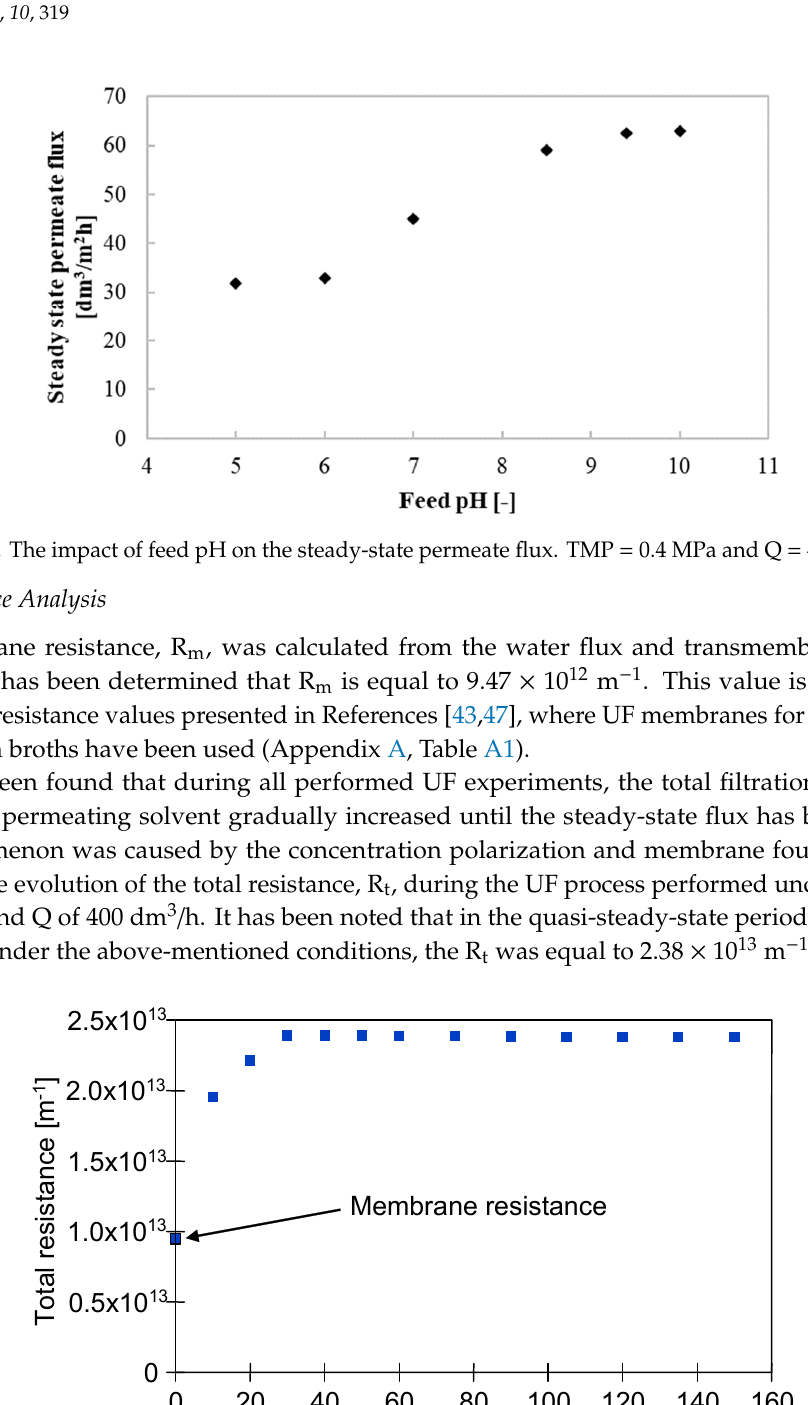
Figure 6. The evolution of the total resistance, R t , under TMP = 0.1 MPa and Q = 400 dm 3 /h.